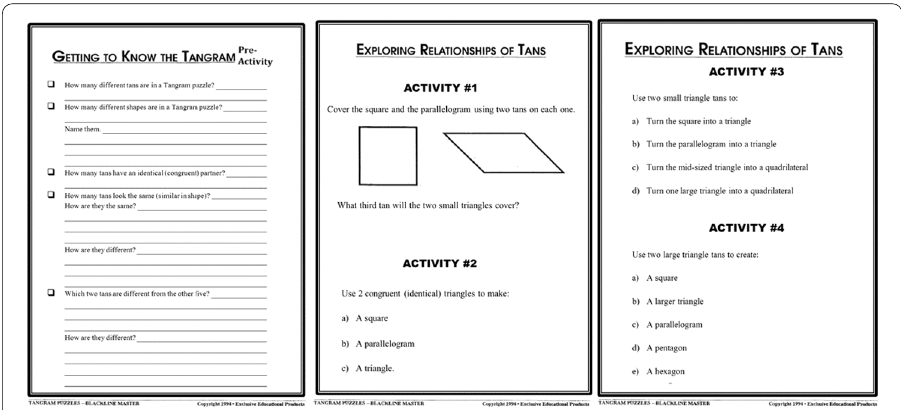
Fig. 3 Pre‑activity Sheets for Stage 1 taken from Tangram Blackline Masters